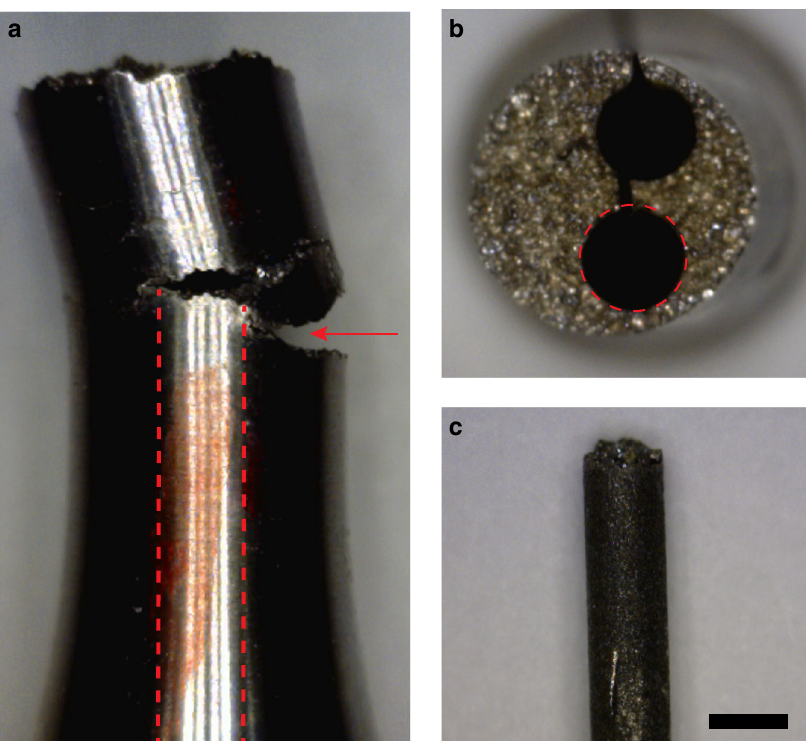
Fig. 6 Sample preparation. Side ( a ) and top ( b ) views of the tensile specimen investigated in the present study. Red dotted lines indicate the approximate location of the core sample shown in c . The red arrow in a indicates the opening of a large secondary crack, on which the present investigation is focused. Scale bar in c : 1